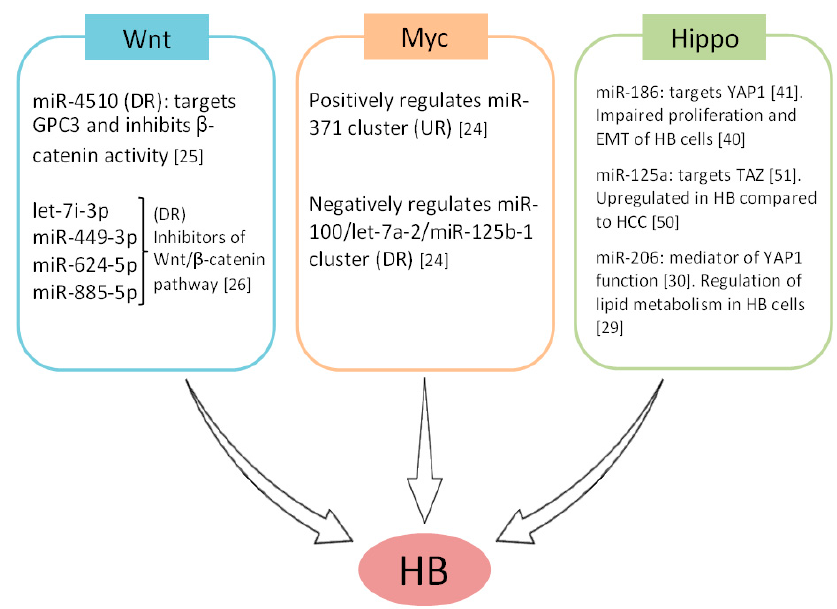
Figure 2. MicroRNAs participating in the key signaling pathways involved in the pathogenesis of hepatoblastoma (HB) tumors. DR: downregulated; UR: upregulated.